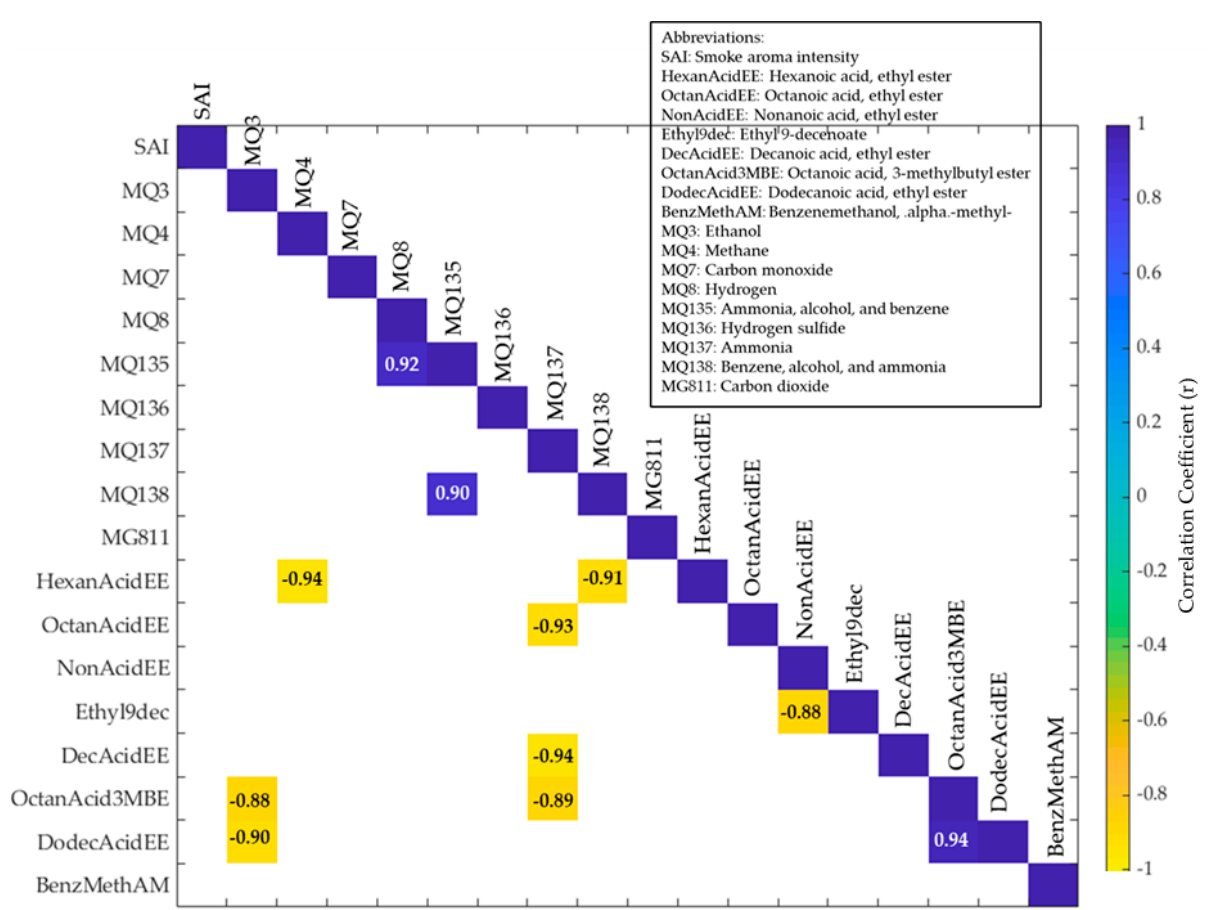
Figure 4. Matrix illustrating the significant ( p < 0.05) correlations between the sensory parameters, e-nose readings, and volatile aroma compounds. Colour bar: the blue side depicts the positive correlations, while the yellow side depicts the negative correlations. Darker blue and yellow colours denote higher correlations.